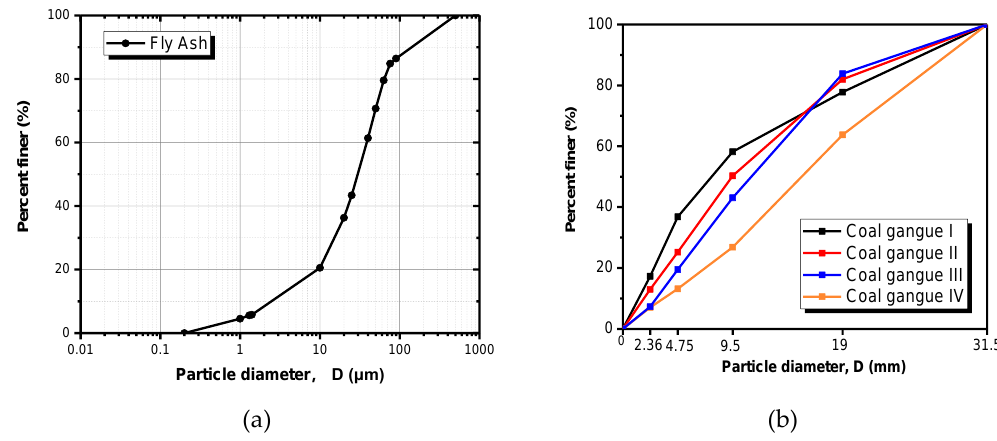
Figure 1. Grading curves of fly ash and coal gangue. ( a ) Fly ash; ( b ) Coal gangue. Table 1. Chemical compositions of cement, fly ash, and coal gangues.